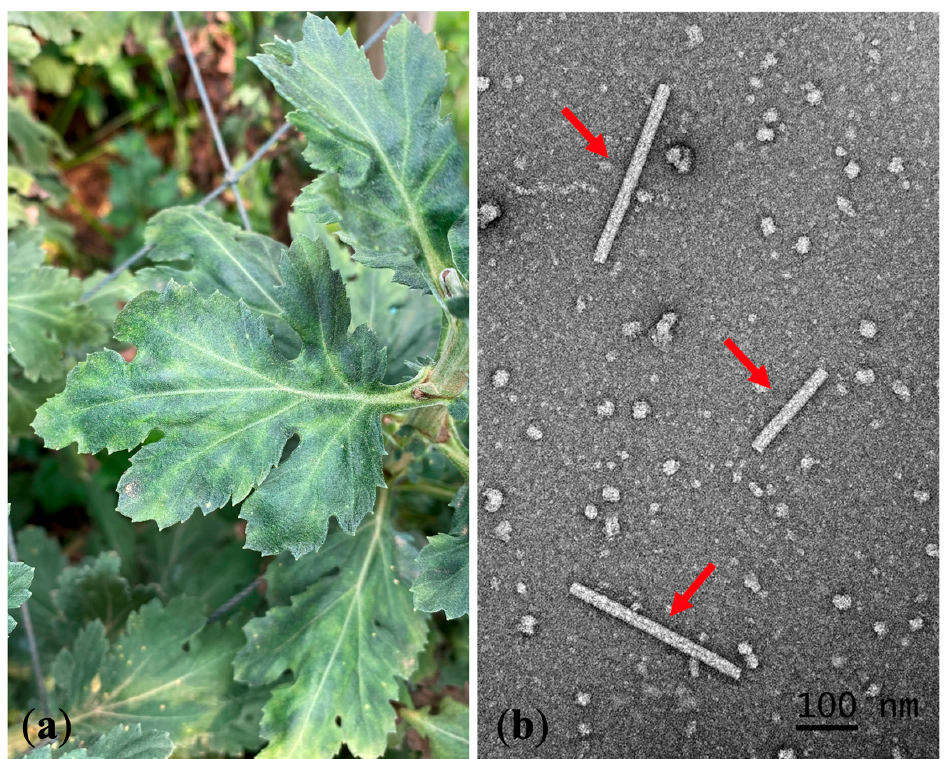
Figure 1. Chrysanthemum leaves exhibiting TMV symptoms and transmission electron micrograph: ( a ) mosaic symptom (dark green area) on naturally infected chrysanthemum leaves; ( b ) transmission electron micrograph of TMV rigid rod structure (red arrows) from a symptomatic chrysanthemum leaf.